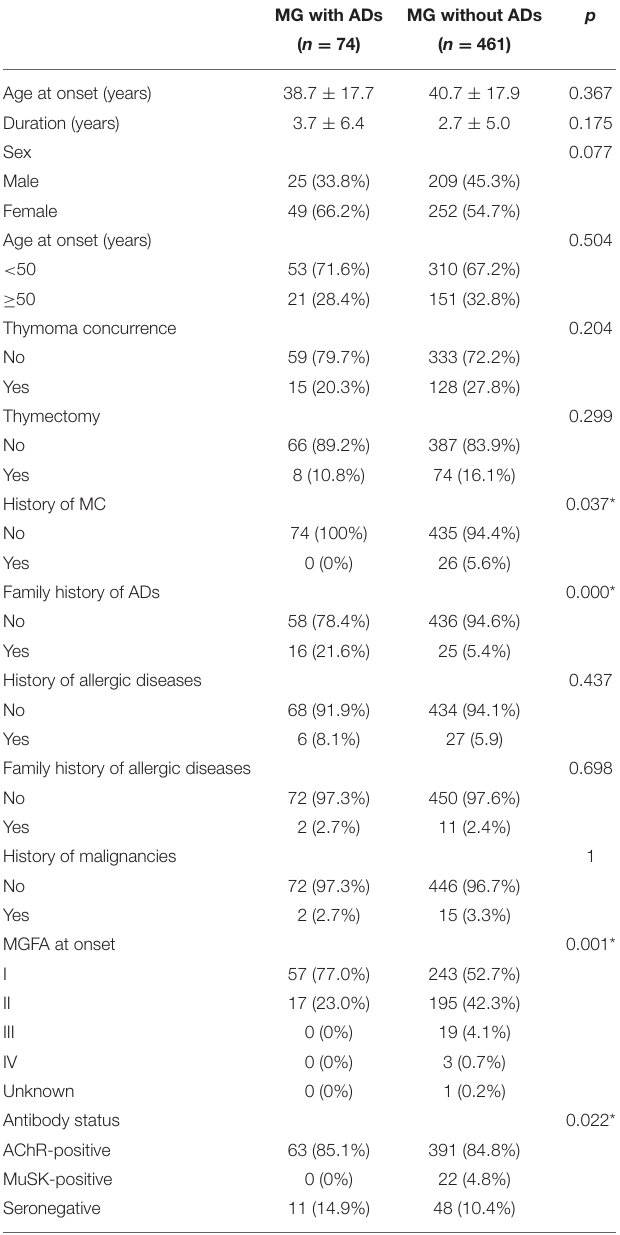
TABLE 3 | Clinical characteristics between patients with MG with and without ADs for whom antibody information were